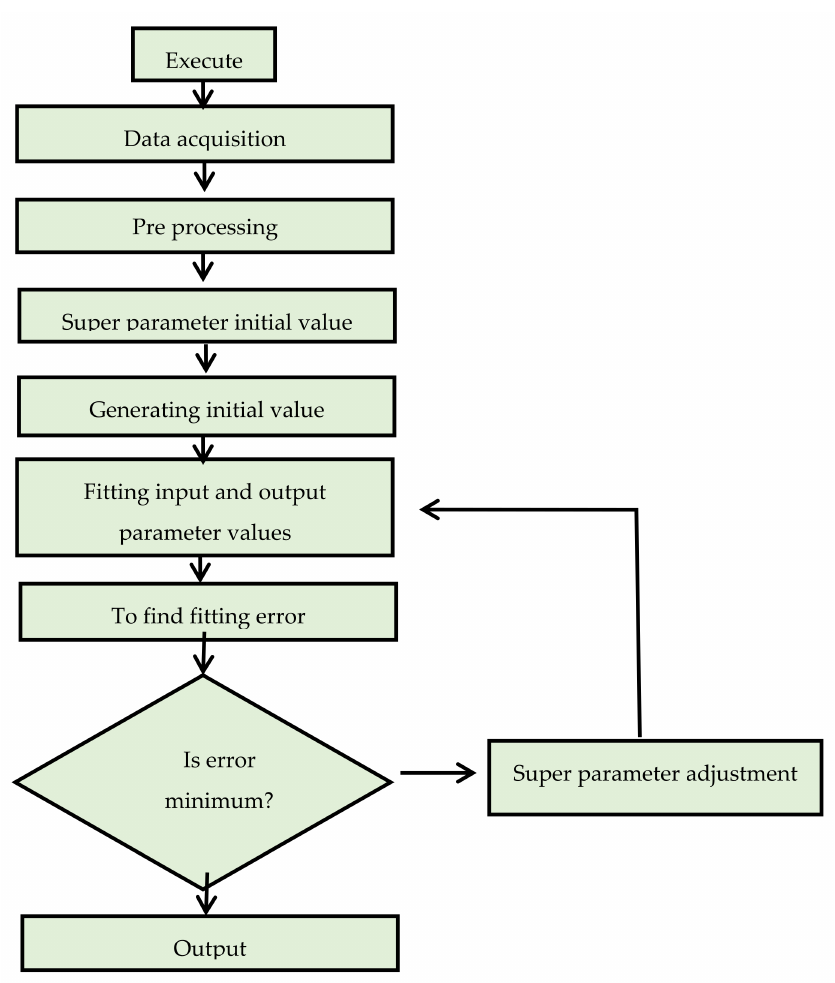
Figure 4. Flow chart of Support Vector